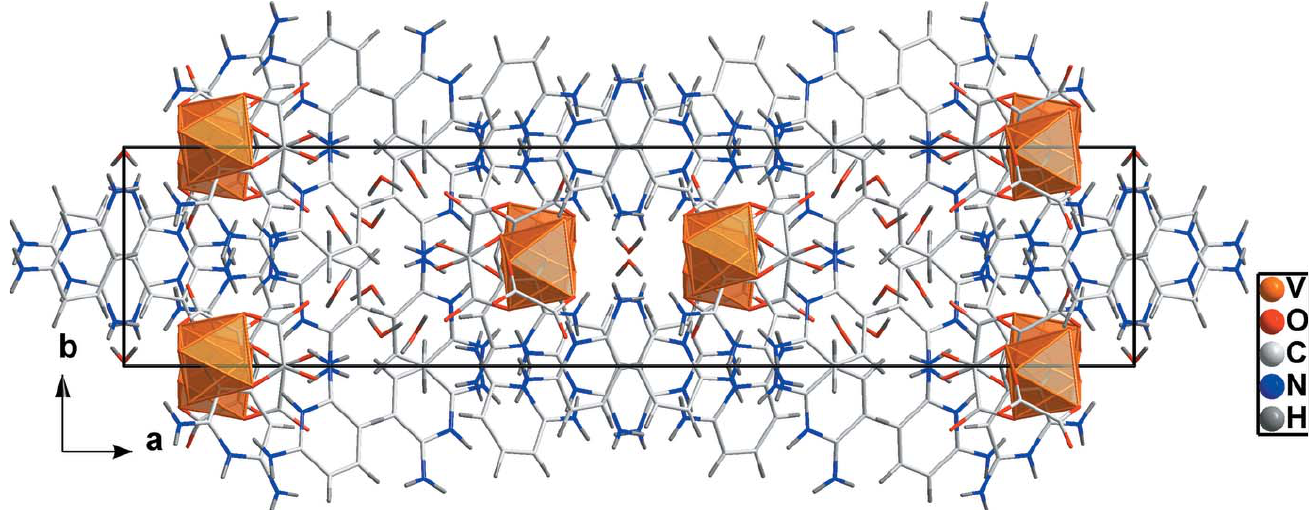
Figure 5 View of the packing of the title compound.